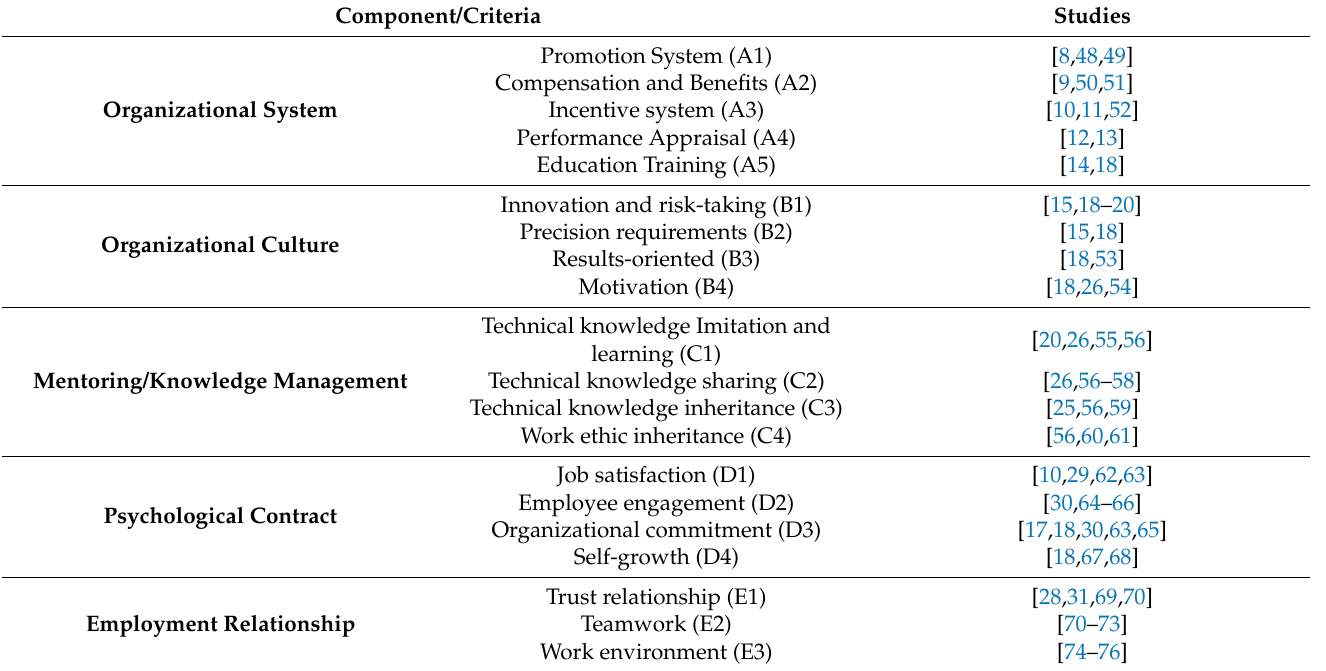
Table 1. Formal research framework components and